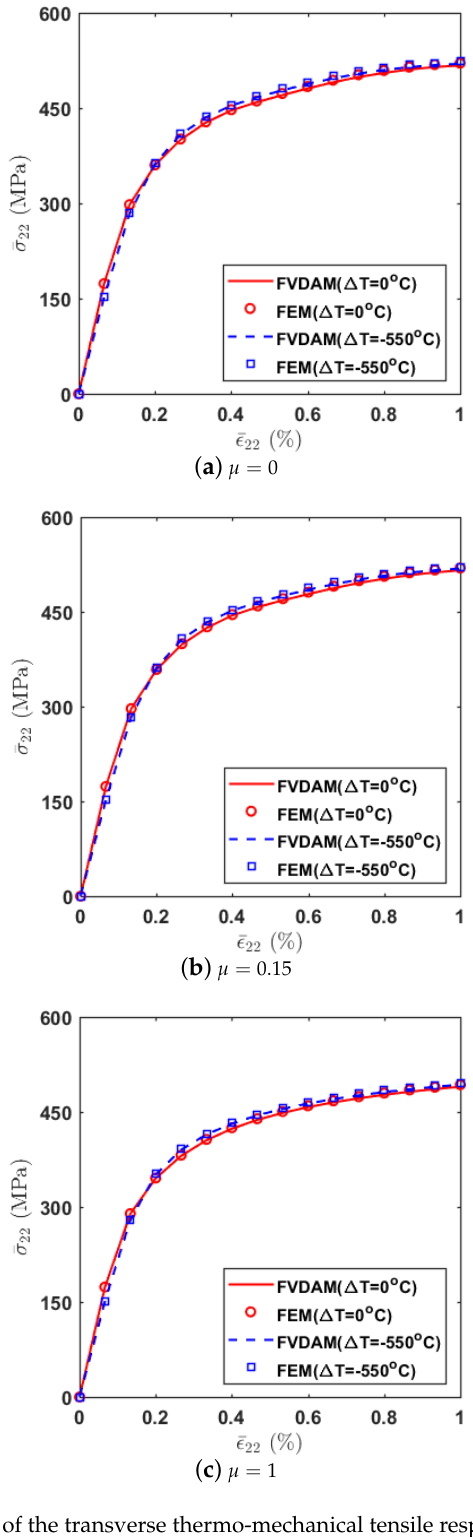
Figure 5. Comparison of the transverse thermo-mechanical tensile response with different µ . The local field distributions considering thermal effects for µ = 0.15 at the applied strain of ¯ ε 22 = 1% are shown in Figure 6. The results of FVDAM correlates well with the FEM prediction and no apparent difference is